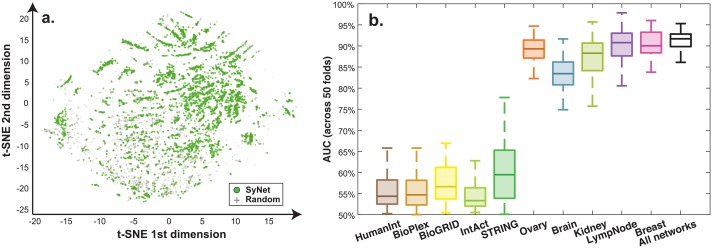
Characterizing SyNet links by a range of graph topological measures.a. t-SNE (unsupervised) visualization of the combined 180 topological measures. Each dot represents one gene pair. Green dots indicate SyNet links while gray markers represent an equal number of random pairs. b. Performance of Lasso model trained over all topological measure for different networks and all networks combined (rightmost bar).